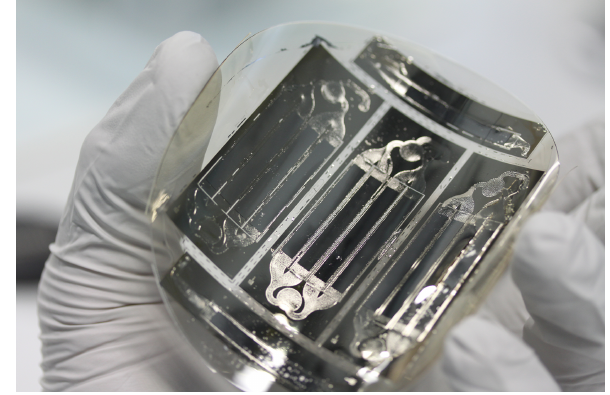
Figure 4. Fabrication of the complete sensor. Part 1: fabrication of the bottom electrode and the microfluidic channels of the sensor chip; part 2: manufacturing of the top electrode and the SU-8 top cap; part 3: establishment of the bonding, dry etching, and plating of the contact pad structures.